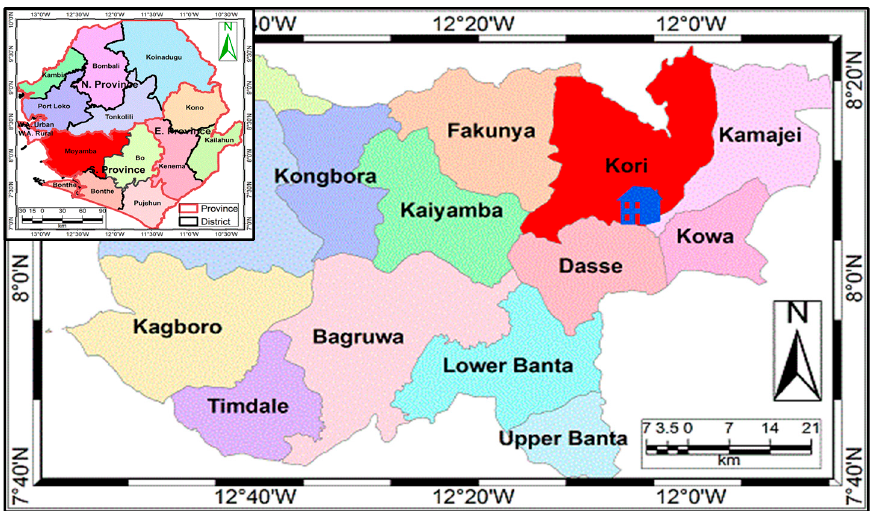
Figure 1. A map depicting Moyamba District (red) in the southern province of Sierra Leone (inset) and then an expanded map of the province (main plate) depicting Kori Chiefdom (red) and the location of the Njala University study area (blue house) in the chiefdom.